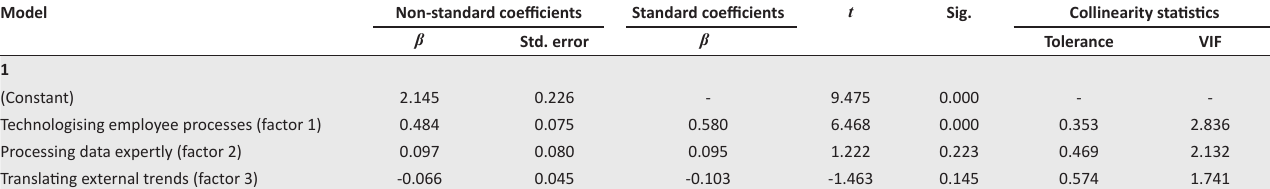
TABLE 2: Extract from the coefficient table in multiple regression analysis.